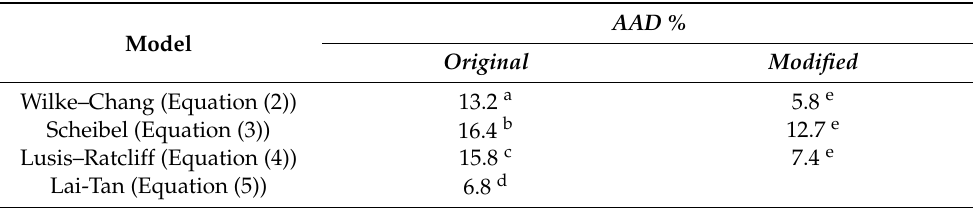
Table 2. The average absolute deviation ( AAD ) for the hydrodynamic models adopted for the prediction of the diffusion coefficients for ethanol in supercritical carbon